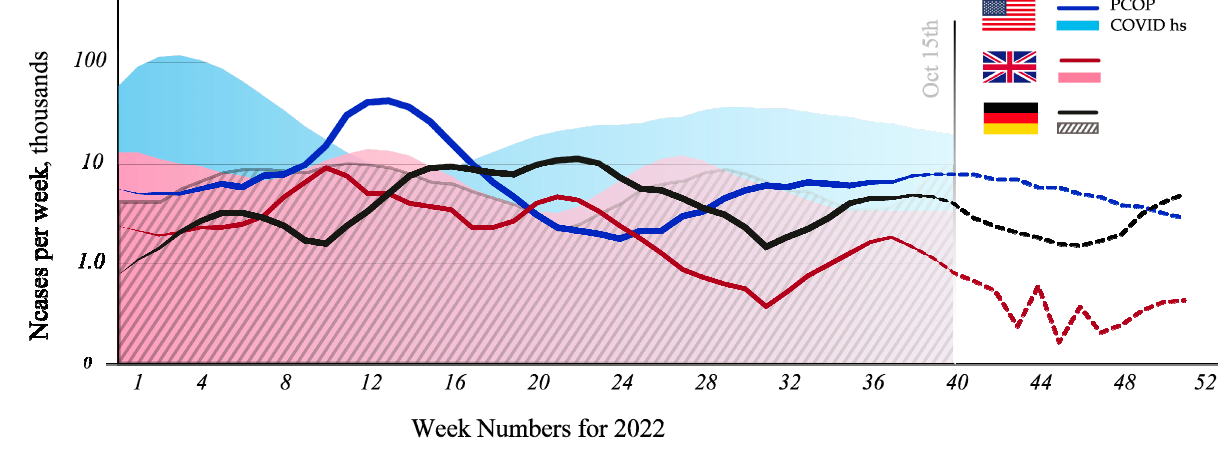
Figure 2. OP-like COVID-19 sequelae 2022 forecast in the USA, UK, and Germany. The number of patients hospitalized with confirmed COVID-19 infection and patients experiencing OP-like symptoms after three months of hospitalization was calculated using ourworldindata.org dataset (accessed on 17 October 2022). The total percentage of survived patients was calculated taking into account the different severity of the disease.